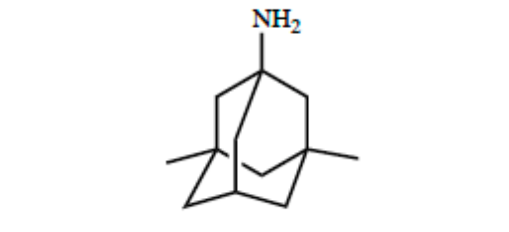
Figure 4. Chemical structure of memantine.